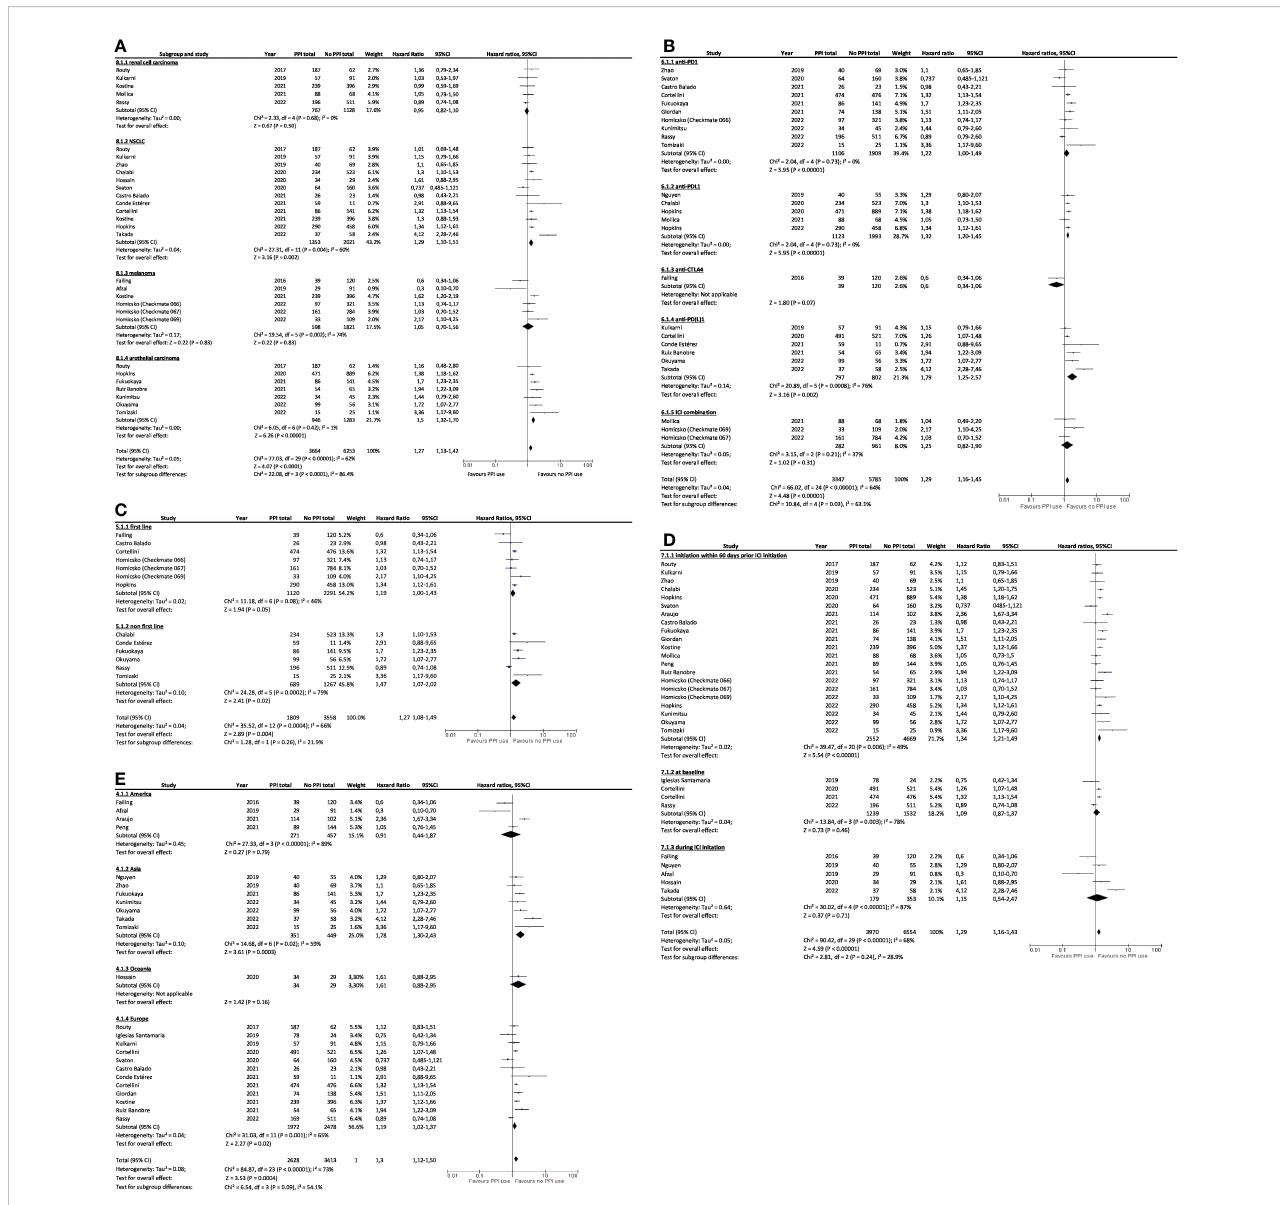
FIGURE 5 Subgroup analysis of association between PPI use and progression-free survival by (A) cancer type, (B) type of immunotherapy, (C) treatment line, (D) PPIs use window, and (E) by continents. PPI, proton pump inhibitor; CI, con fi dence interval; NSCLC, non-small cell lung cancer; ICI, immune checkpoint